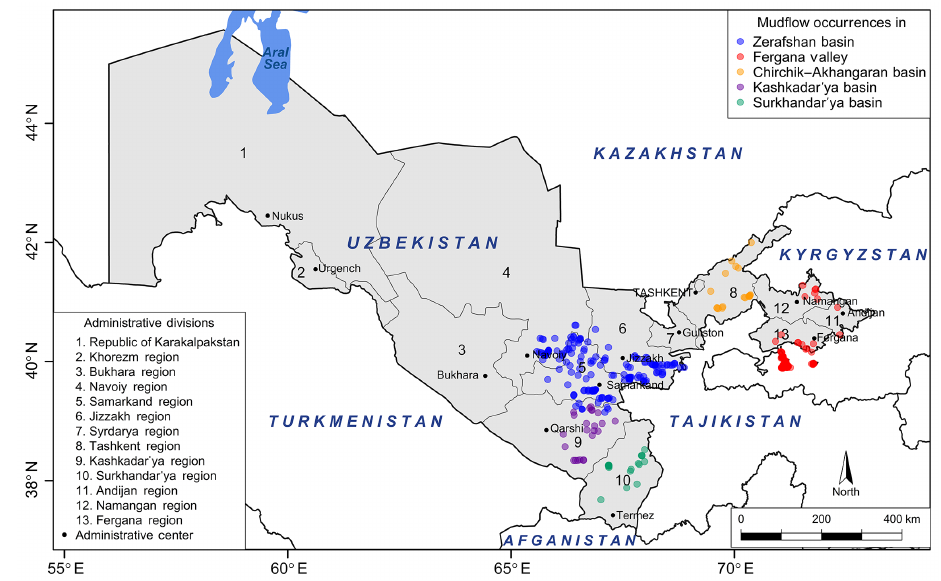
Figure 1. Mudflow occurrences for the years 2005–2014 in areas with a high probability of mudflow passage in Uzbekistan include the following: Zerafshan basin (blue dots) in the central part of the country; Fergana Valley (red dots) in the east; Chirchik–Akhangaran basin (orange) in the north-east; Surkhandar’ya (green) and Kashkadar’ya (violet) river basins in the south of Uzbekistan. The map also represents political administrative divisions and administrative centres/cities of the